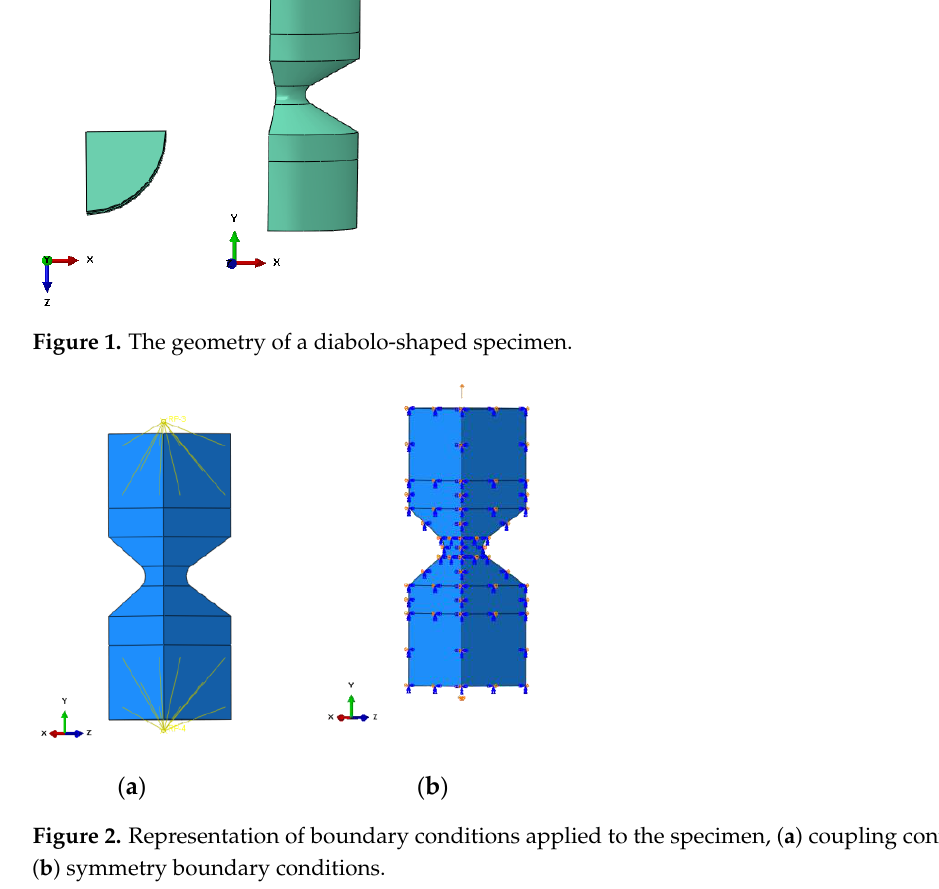
Figure 1. The geometry of a diabolo-shaped specimen.